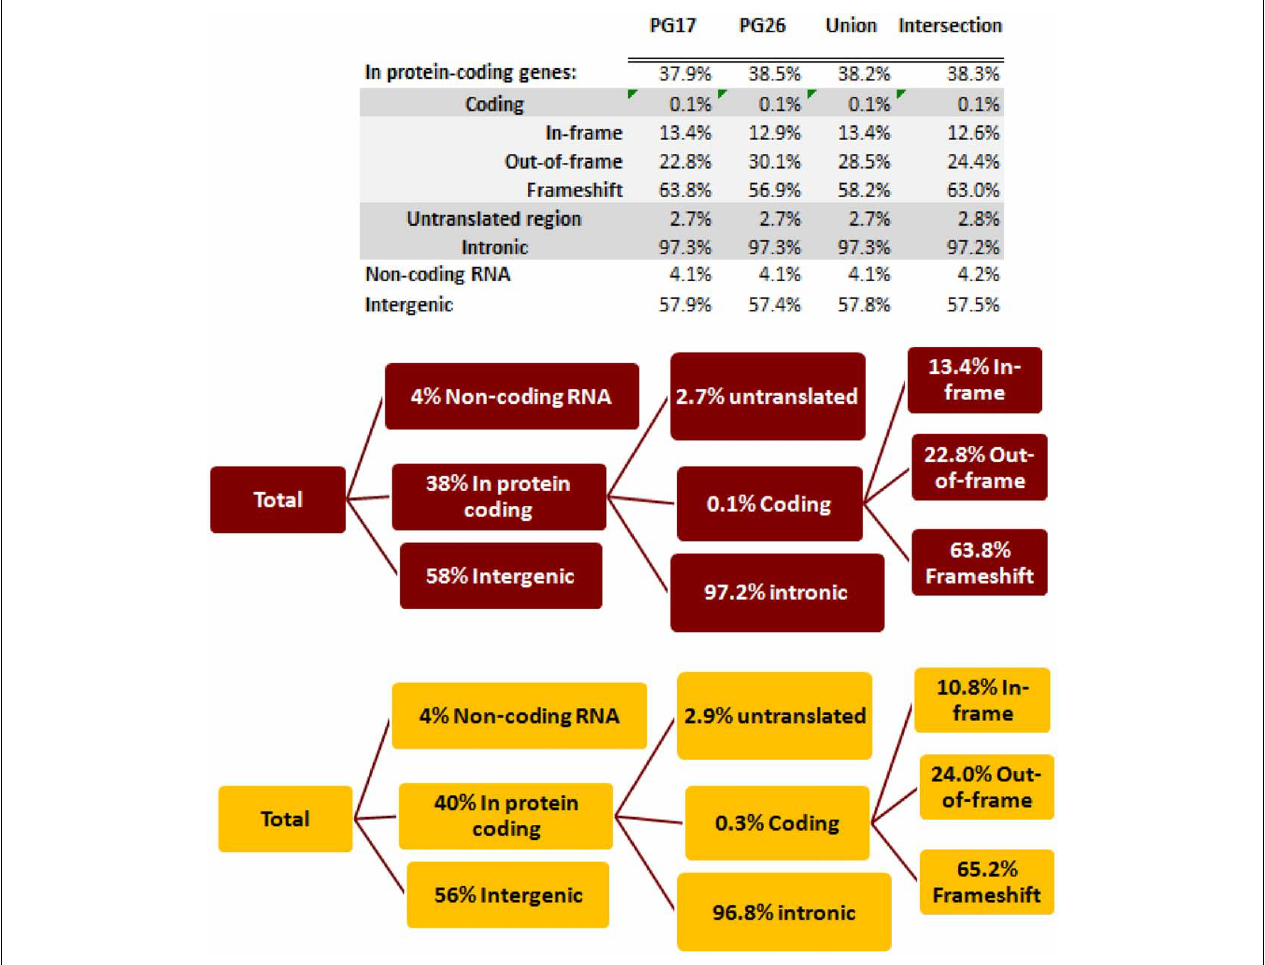
FIGUREA8 | Functional analysis of the insertions detected in PG17 and PG26, their union and intersection. The chart in maroon shows the breakdown of insertions and the rate of coding insertions in PG17 and PG26.The chart in orange shows the summary of insertions in nine whole genomes generated from complete genomics and annotated in the same way as PG17 and